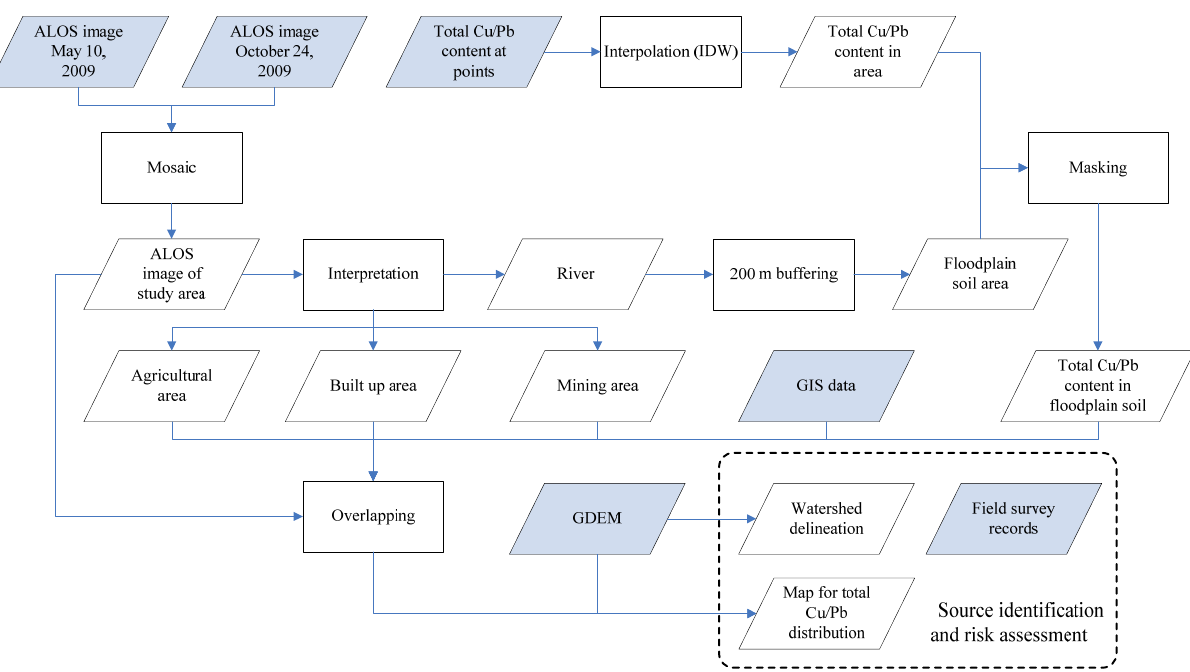
Figure 2. Flowchart of mapping total Cu and Pb contaminations.